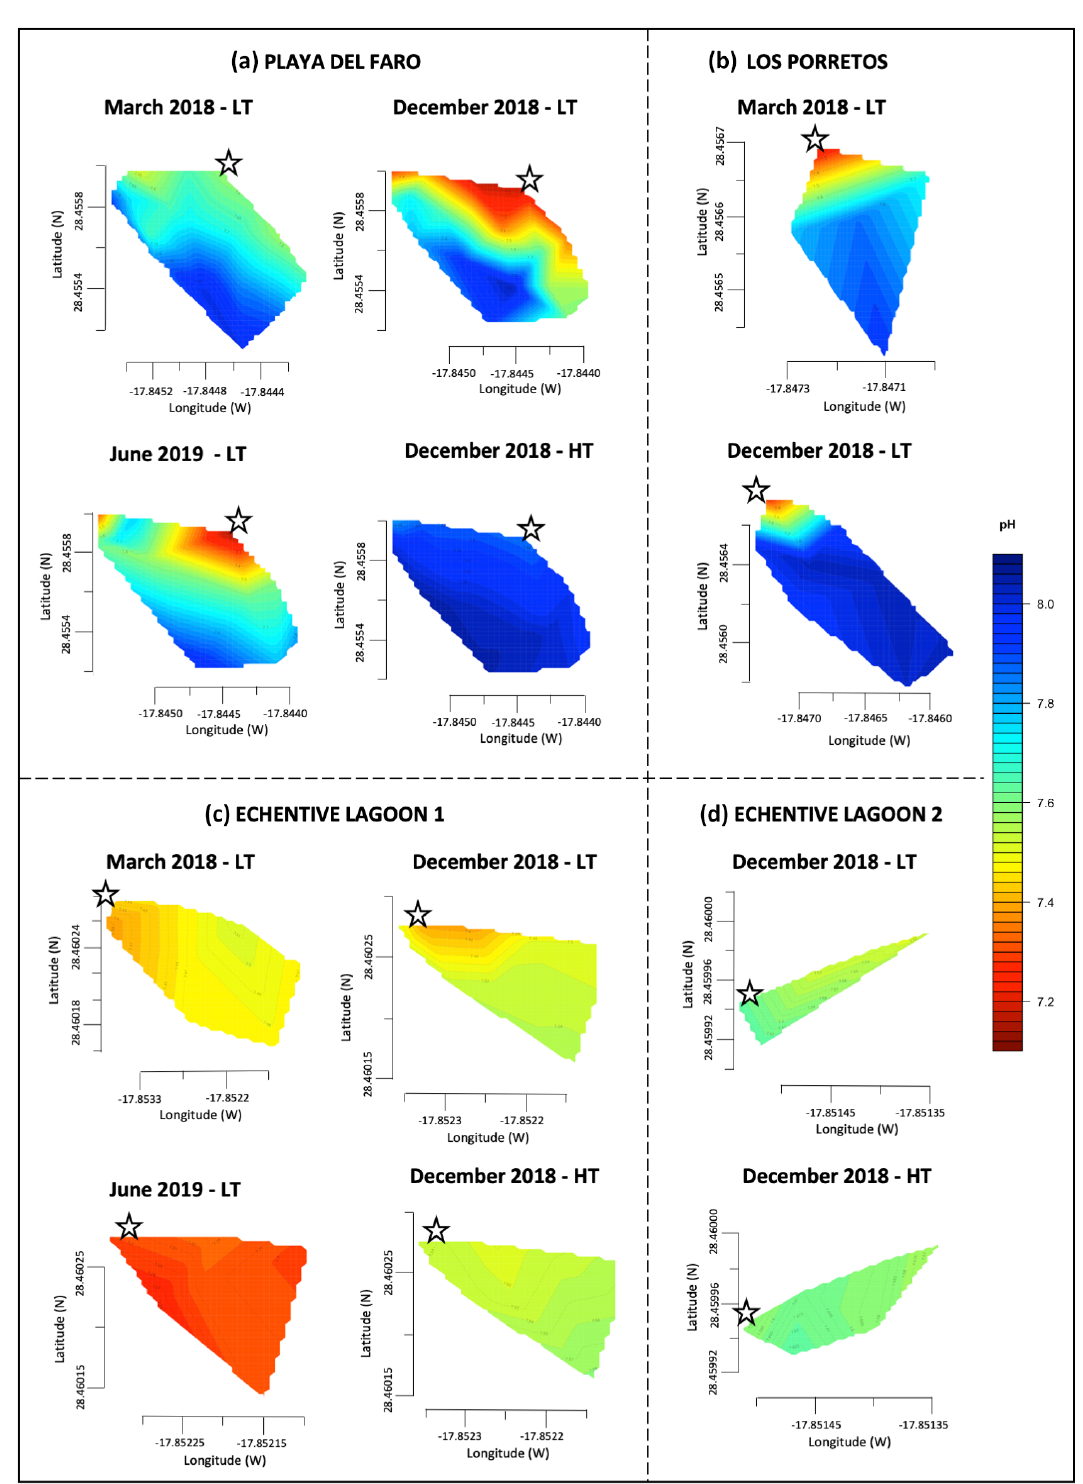
Figure 2. Linear interpolation graphs of pH values that were collected in March 2018, December 2018 and June 2019 during low tide (LT) and high tide (HT) on Playa del Faro (a) , on Los Porretos (b) , in Echentive lagoon 1 (c) and in Echentive lagoon 2 (d) . The star symbol is the reference mark on the map in Fig.